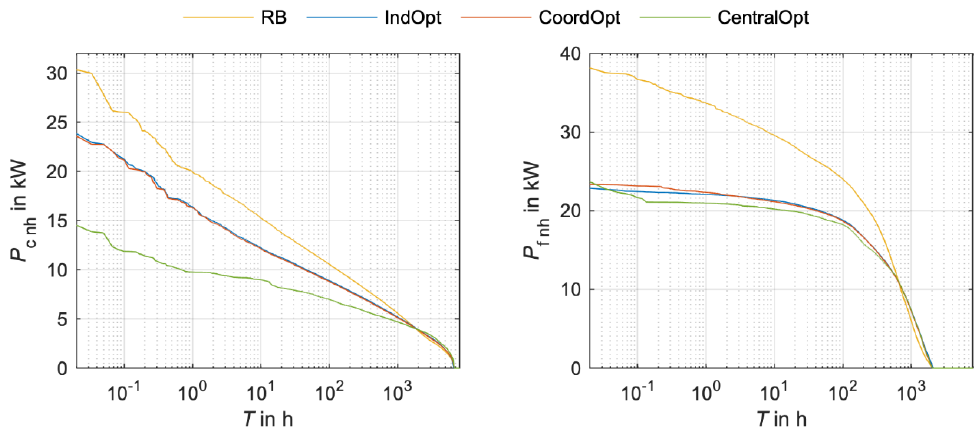
Figure 15. Duration curves of the power consumed from the superordinate grid (left) and the power fed into the superordinate grid fed into the superordinate grid (right).